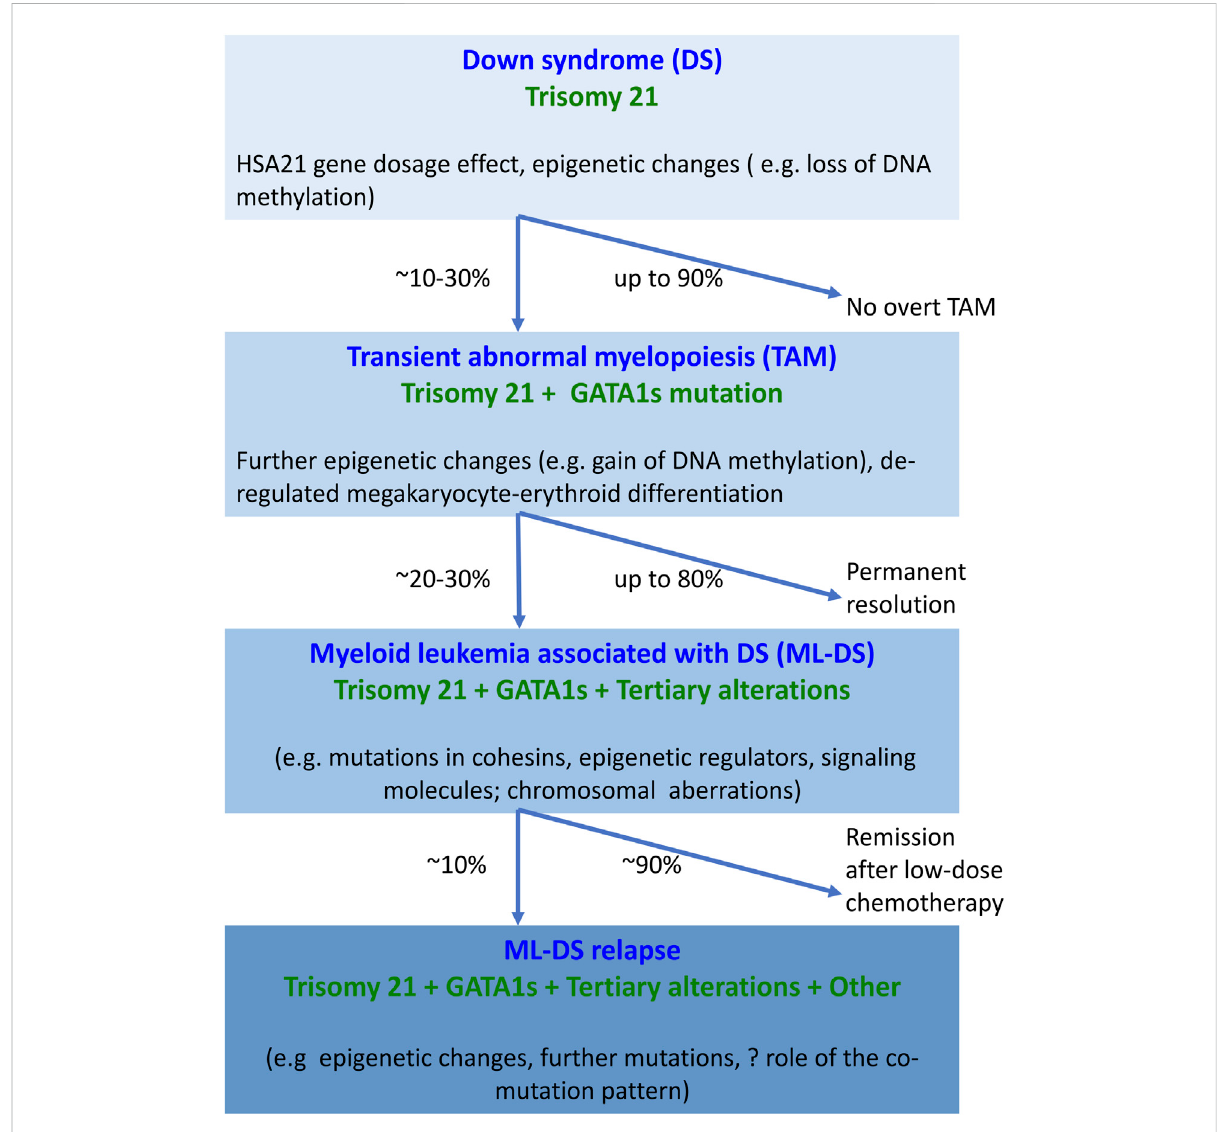
FIGURE 1 OverviewofmolecularchangesreportedatdifferentstagesofmyeloidproliferationassociatedwithDownsyndrome.Trisomy21alonedisturbs hematopoiesis through the increased dosage of HSA21-located genes and alterations in the epigenome, resulting in increased megakaryopoiesis. The combination of trisomy 21 and GATA1s causesexpansion of megakaryocytic progenitors. Progression of TAM to ML-DS requires the interaction of GATA1s with additional somatic mutations and chromosomal structural abnormalities. Little is known about the molecular landscape of refractoryorrelapsedML-DS.Abbreviations:DS,Downsyndrome;GATA1s,GATA1short;HSA21,humanchromosome21;ML-DS,myeloidleukemia associated with Down syndrome; TAM, transient abnormal